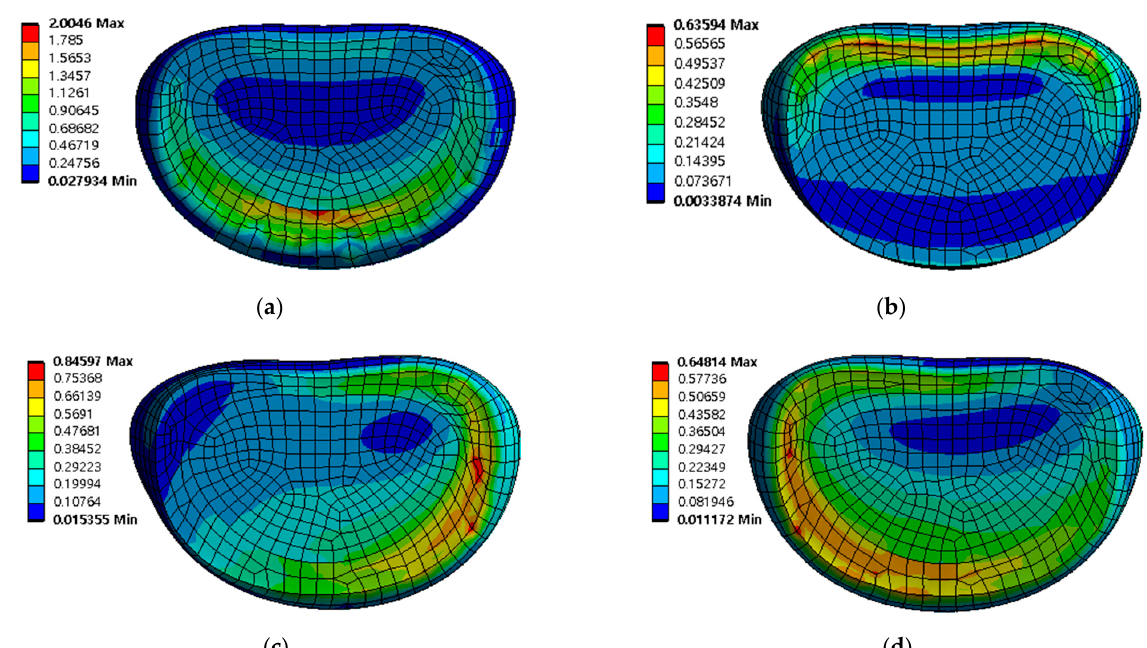
Figure 9. Equivalent stress per range of motion (ROM) of adjacent intervertebral disc (IVD) of L5-S1 at different porosities of the spinal implants in each spinal motion: ( a ) flexion; ( b ) extension; ( c ) lateral bending; ( d ) rotation.